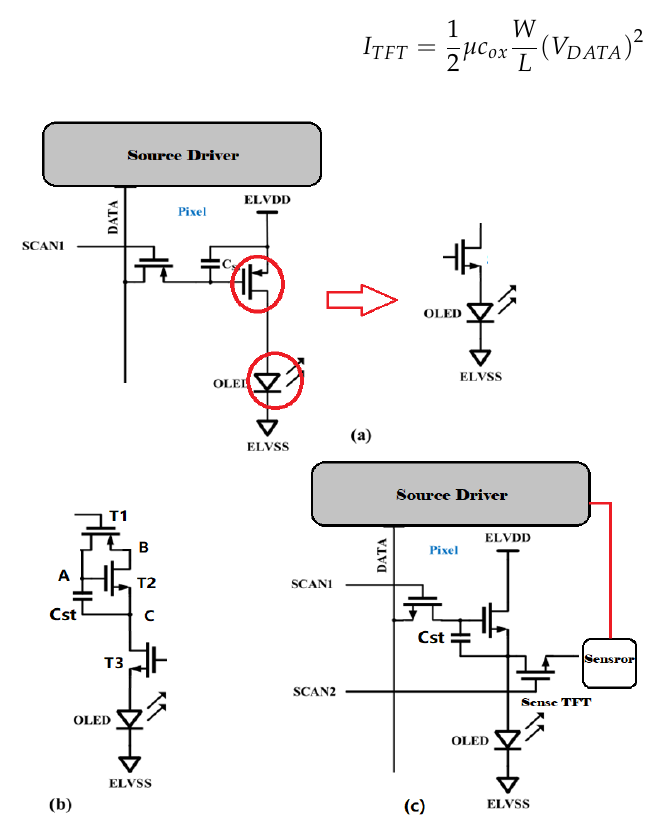
Figure 3. Degradation of TFTs and OLEDs and compensation technology: ( a ) Degradation in 2T1C circuit. ( b ) Internal compensation method. ( c ) External compensation method.